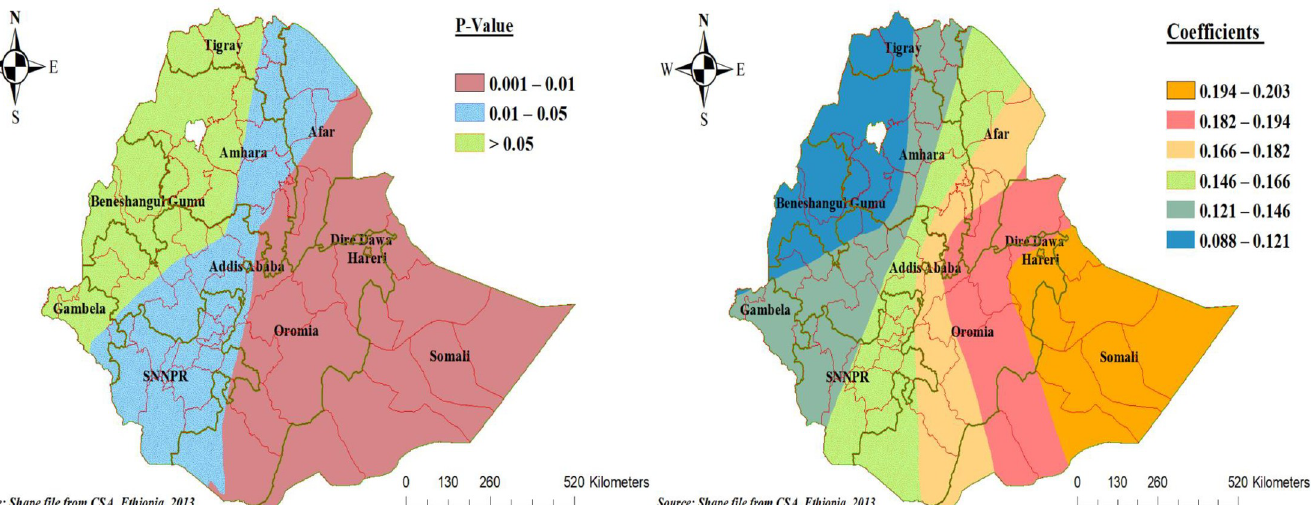
PLOS ONE | https://doi.org/10.1371/journal.pone.0252639 June 3,